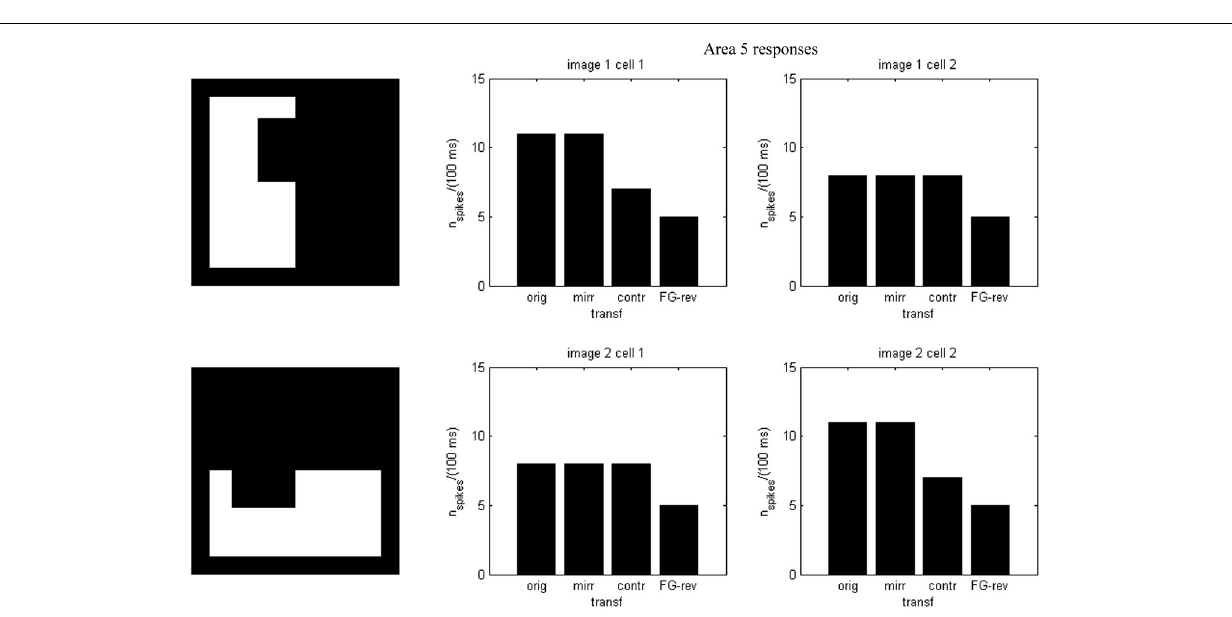
of the original one. Depending on the lengths of horizontal and vertical borders, the different activity of the output units classifies the elements of these sets. In addition, responses are similar for original, mirror-reversed and contrast-reversed transformations of the same image, and significantly decrease for the FG-reverse